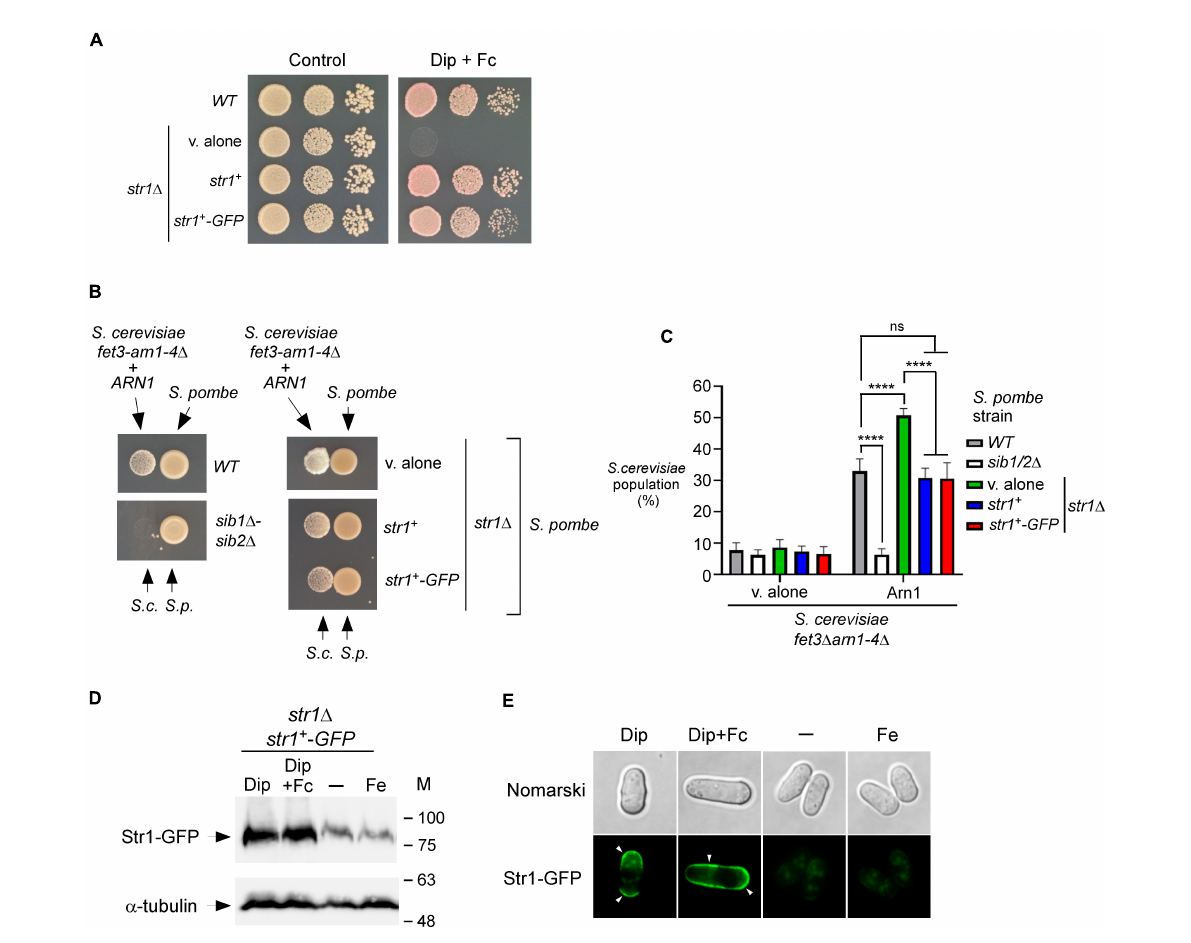
FIGURE3 str1 + gene disruption in S. pombe favors Fc-dependent growth of an S. cerevisiae fet3 (cid:49) arn1-4 (cid:49) mutant expressing ARN1 . (A) S. pombe str1 (cid:49) strain containing an empty vector (v. alone) or expressing str1 + and str1 + -GFP alleles were grown to an OD 600 of 1.0. Cells were spotted in serial dilutions onto YES medium containing Dip (140 µ M) and Fc (2 µ M) (right side). Cell viability of S. pombe wild-type (WT) and str1 (cid:49) strains was assayed on untreated medium (control, left side). (B) S. pombe wild-type, sib1 (cid:49) sib2 (cid:49) , and str1 (cid:49) strains were grown to an OD 600 of 1.0